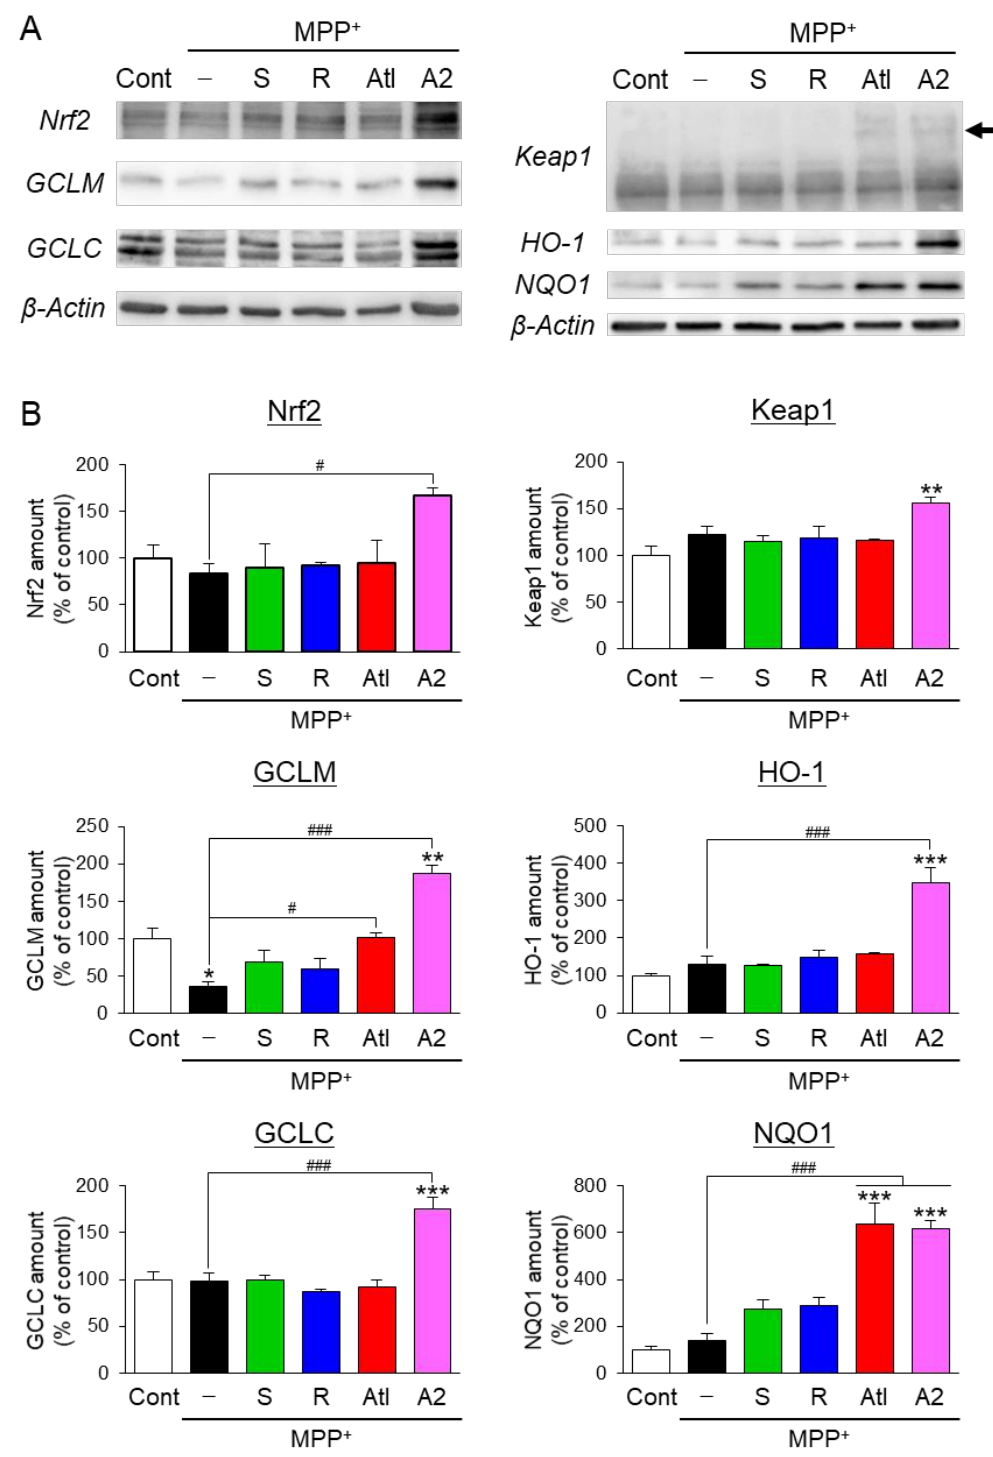
Figure 6. Effects of ar-turmerone analogs on Nrf2-related proteins in LUHMES cells. ( A ) Representative immunoblot images of Nrf2, GCLM, GCLC, Keap1, HO-1, NQO1, and β -actin in LUHMES cells under control conditions, treated with MPP + (10 µ M), and cotreated with MPP + and ar-turmerone analogs (20 µ M). Whole images of immunoblotting are presented in Figure S3. The arrow in the Keap1 blot indicates high-molecular-weight bands detected in cells treated with Atl and A2. ( B ) Quantitative analyses of immunoreactive bands of Nrf2, GCLM, GCLC, Keap1, HO-1, and NQO1. The band intensities were normalized with the immunoreactivity of β -actin as an internal control. Data are presented as the mean ± SEM of three independent samples. * p < 0.05, ** p < 0.01, *** p < 0.001 vs. control, # p < 0.05, ### p < 0.001 (n = 3, one-way ANOVA, followed by a post hoc Tukey test).